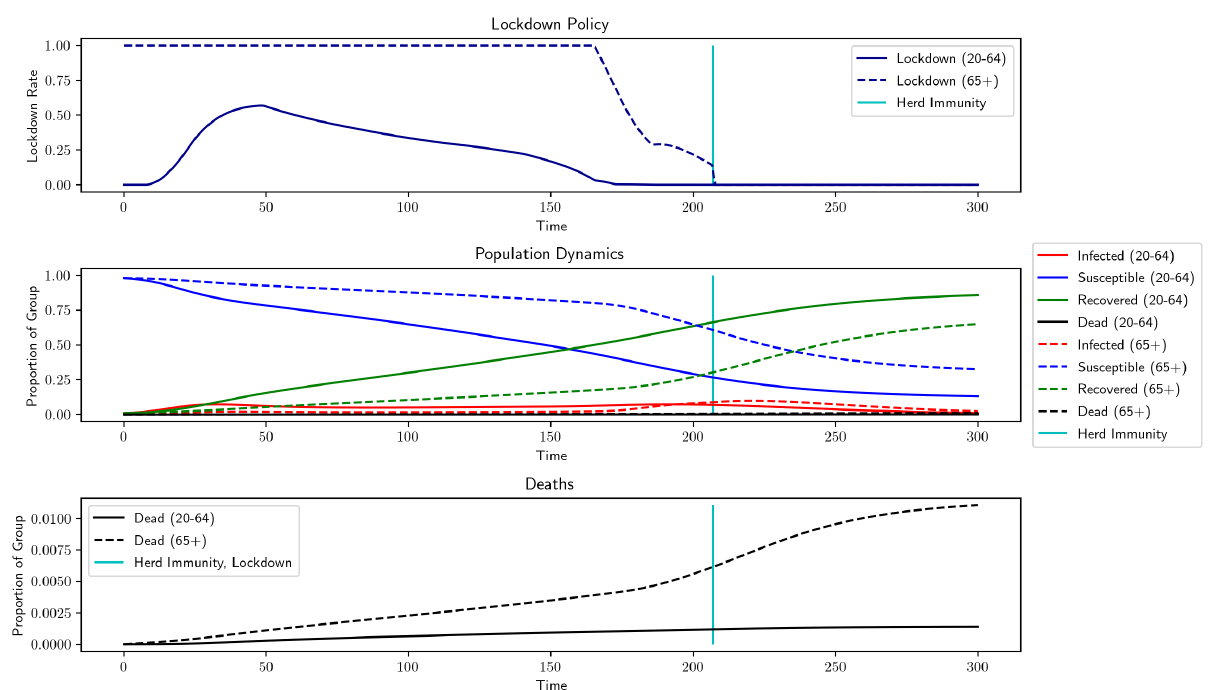
Figure 4. Proposed model with lower death rates from Table 1 ( χ = 0.2/ r , all others from Table A1). Herd immunity: 80 d, output loss: 0%, total deaths: 0.4464%.